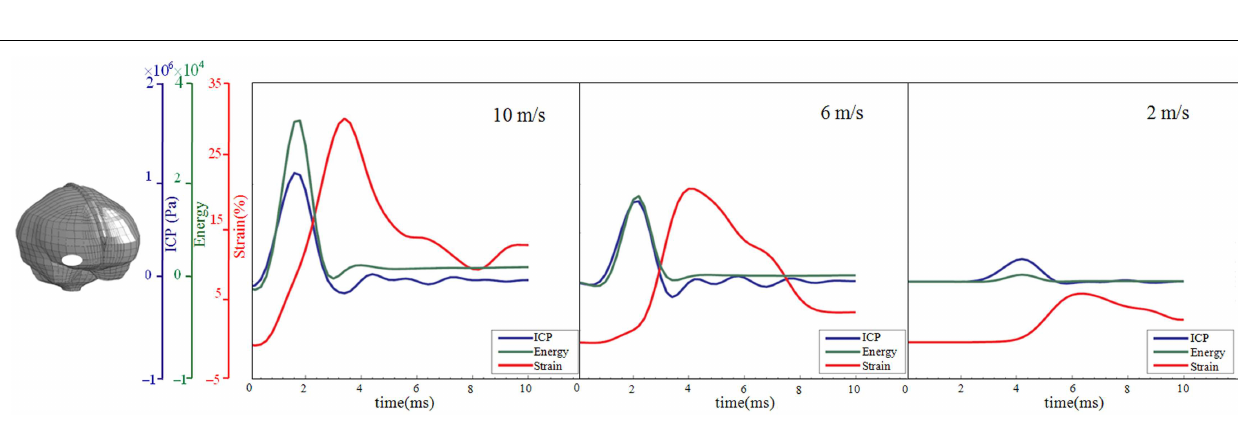
represents the time after impact, and y axis represents the values of ICP (blue), strain energy density (green), and first principal strain (red). From left to right are the results for the impact velocities of 10, 6, and 2m/s